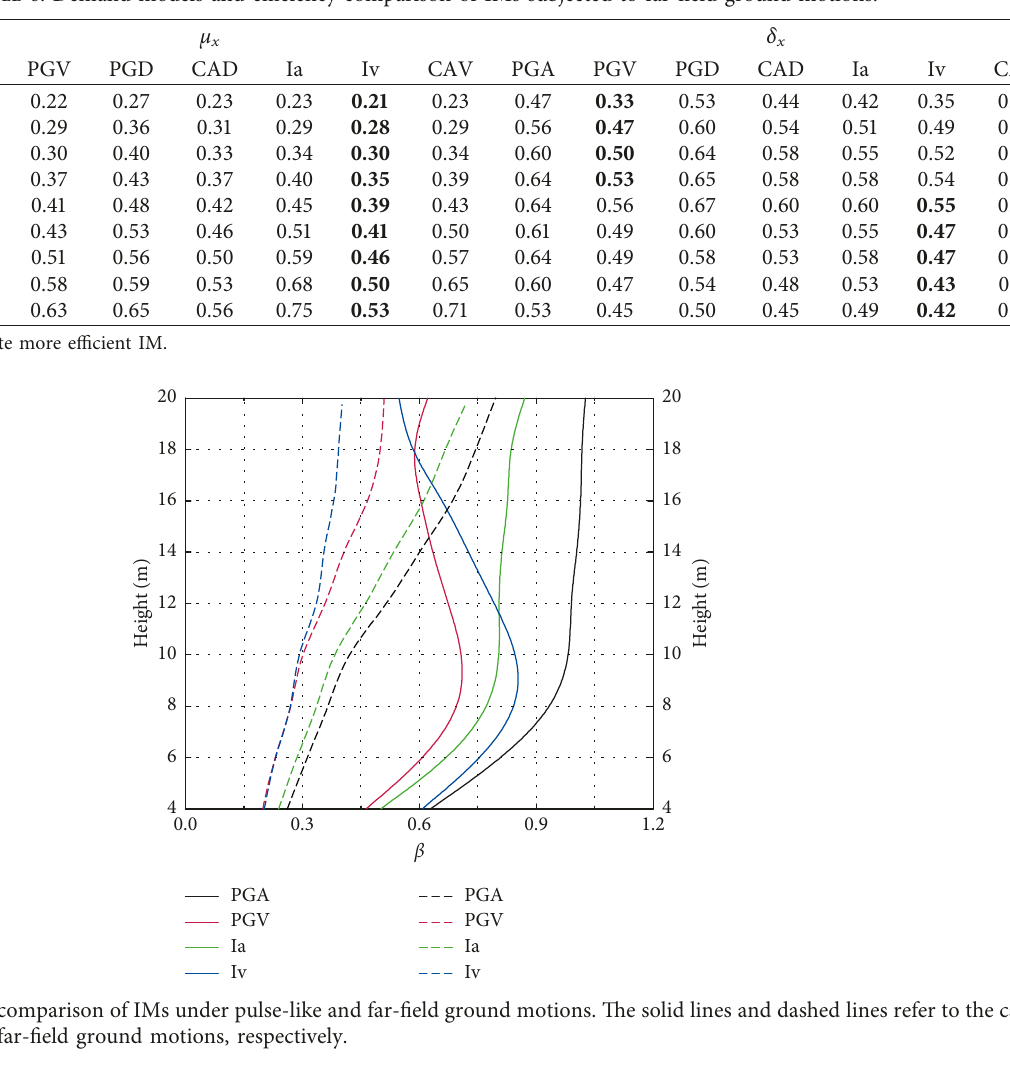
Figure 12: IMs efficiency comparison for (a) the bearing deformation along the longitudinal direction and (b) the bearing deformation along the transverse direction. Table 6: Demand models and efficiency comparison of IMs subjected to far-field ground motions.